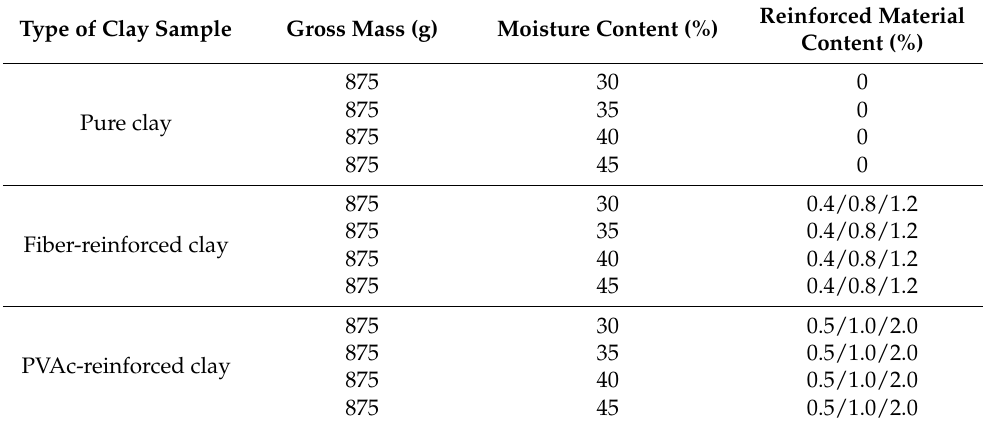
Table 4. Test variables of clay–rock